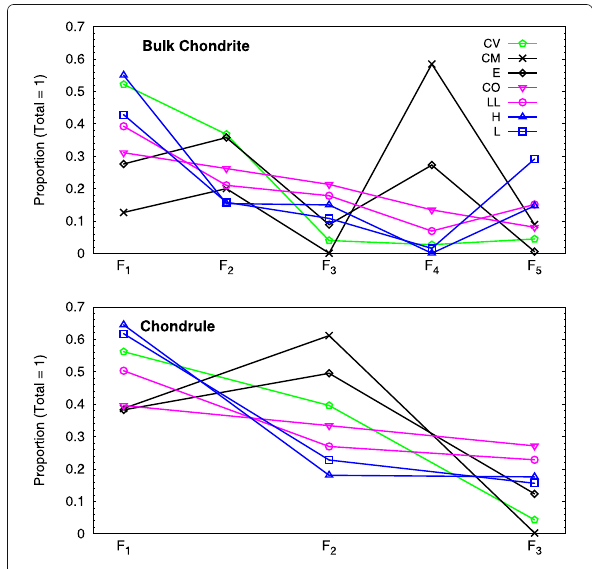
Fig. 6 Top panel: Proportions of the five components, F n ’s in the bulk chondrite determined by the calculation for each chondrite type. F 1 : jet-droplet. F 2 : differential vapor. F 3 : integrated vapor. F 4 : final integrated vapor. F 5 : CI ∗ dust. Bottom panel: Proportions of the three components used for formation of the average chondrule